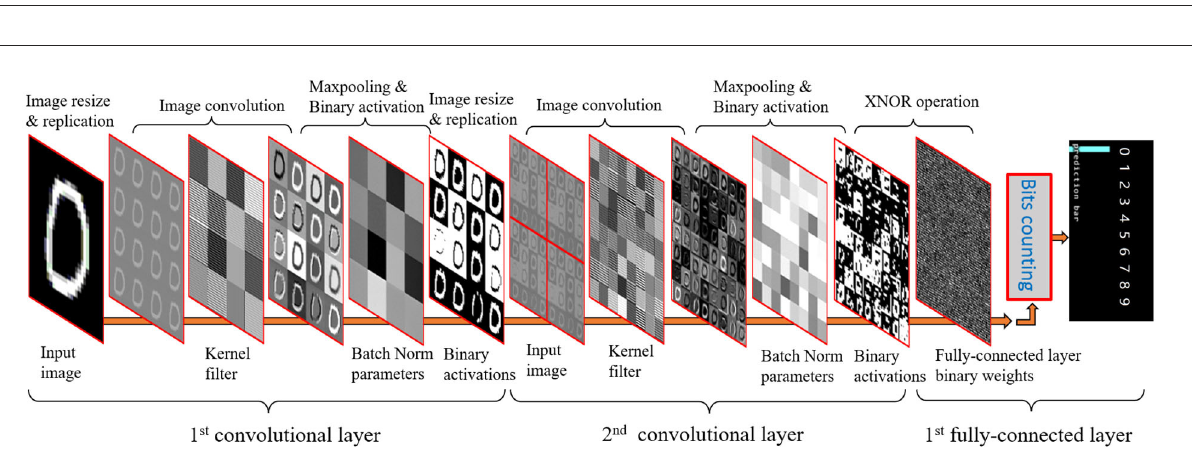
FIGURE4 Two examples of dynamic swapping architectures. (Left) A CNN classification tree where each module is loaded dynamically as needed based on the switching CNN. (Right) A shared convolution module first processes the input and each distinct task use its own sub-modules that are loaded one at a time to produce the different outputs.